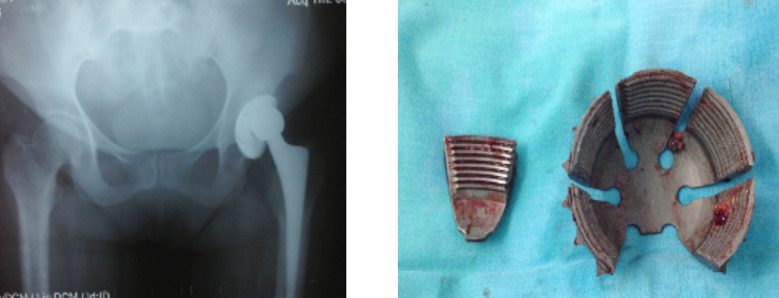
(a) Implant radiograph and photo of a 53-year-old female patient. The patient underwent revision surgery with the diagnosis of acetabular cup breakage in the 12th year of THA. (b) The broken wing of the acetabular cup during revision surgery.